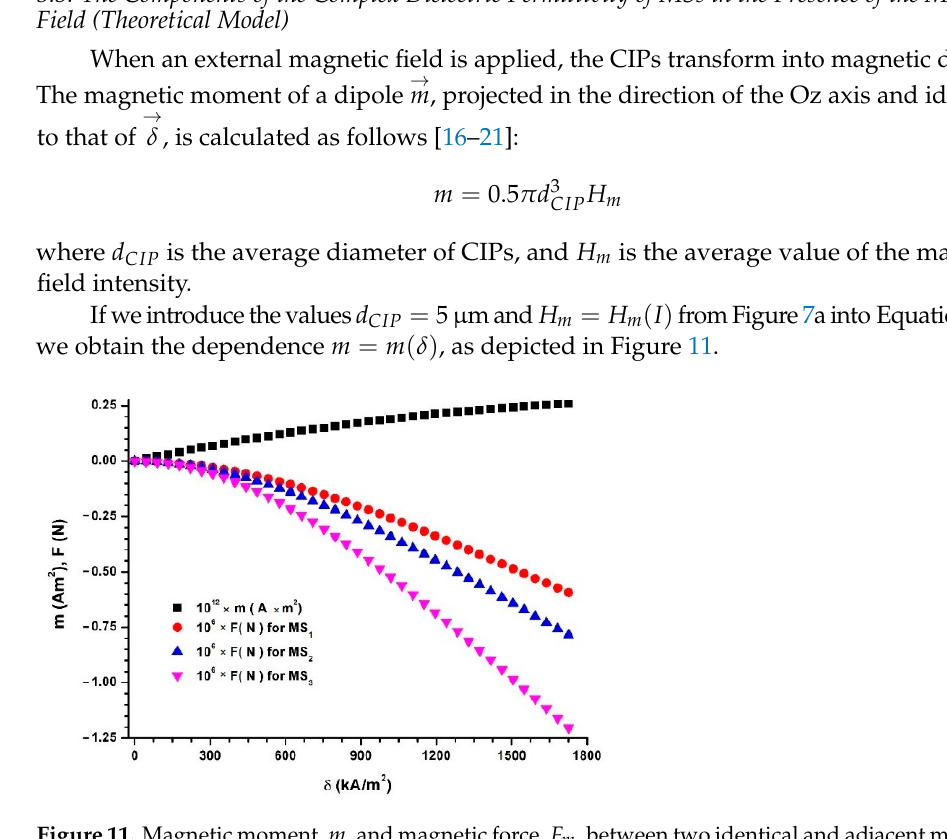
Figure 11. Magnetic moment, m , and magnetic force, F m , between two identical and adjacent magnetic dipoles in MSs as functions of the magnetic field intensity gradient, δ .